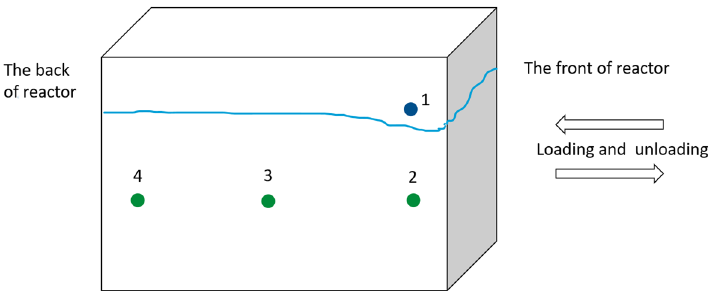
Figure 3. Schematic location of measurement points in the industrial reactor. 1—measurement point of the internal air; 2—measurement point in waste bed in the front; 3—measurement point in waste bed in the middle; 4—measurement point in waste in the back; blue line—the waste fill level of the reactor.